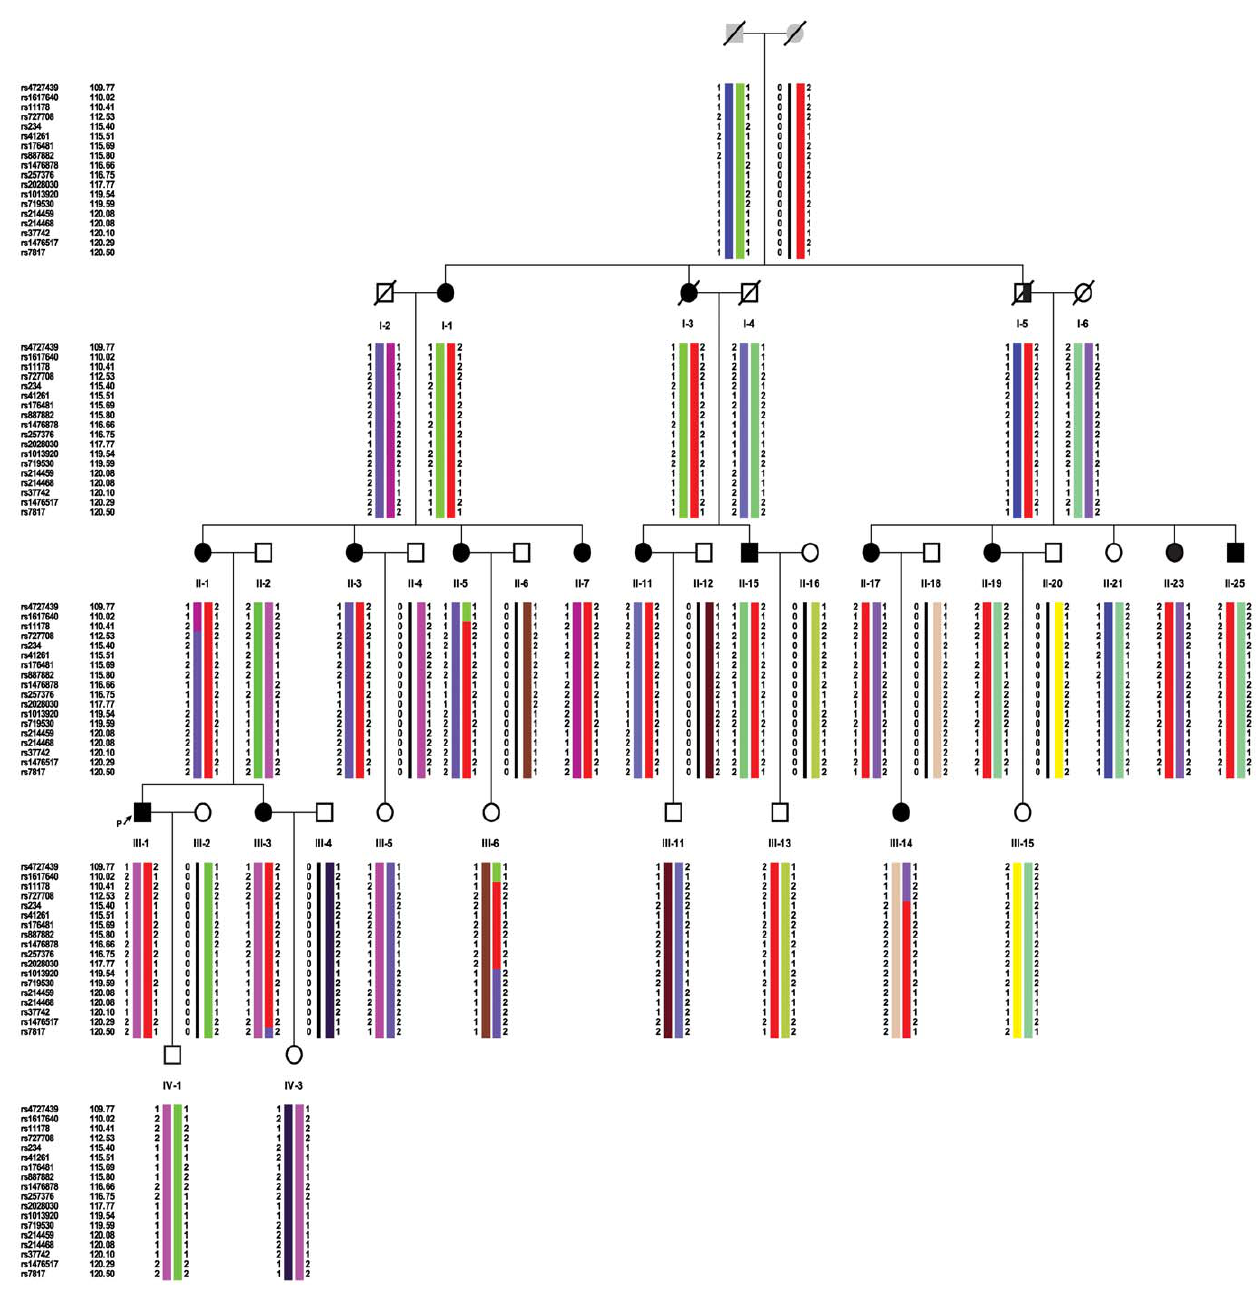
Figure 5. Suggested haplotypes of chromosome 7q22.1-31.1 linked to HIBM in the pedigree. The common region shared by all affected individuals of the pedigree is indicated by the red